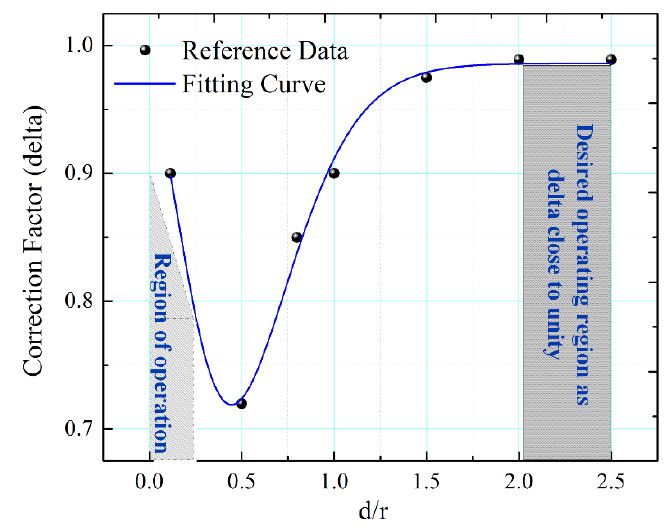
Figure 9. Correction factor δ Vs d/r for hemi-sphere profile.